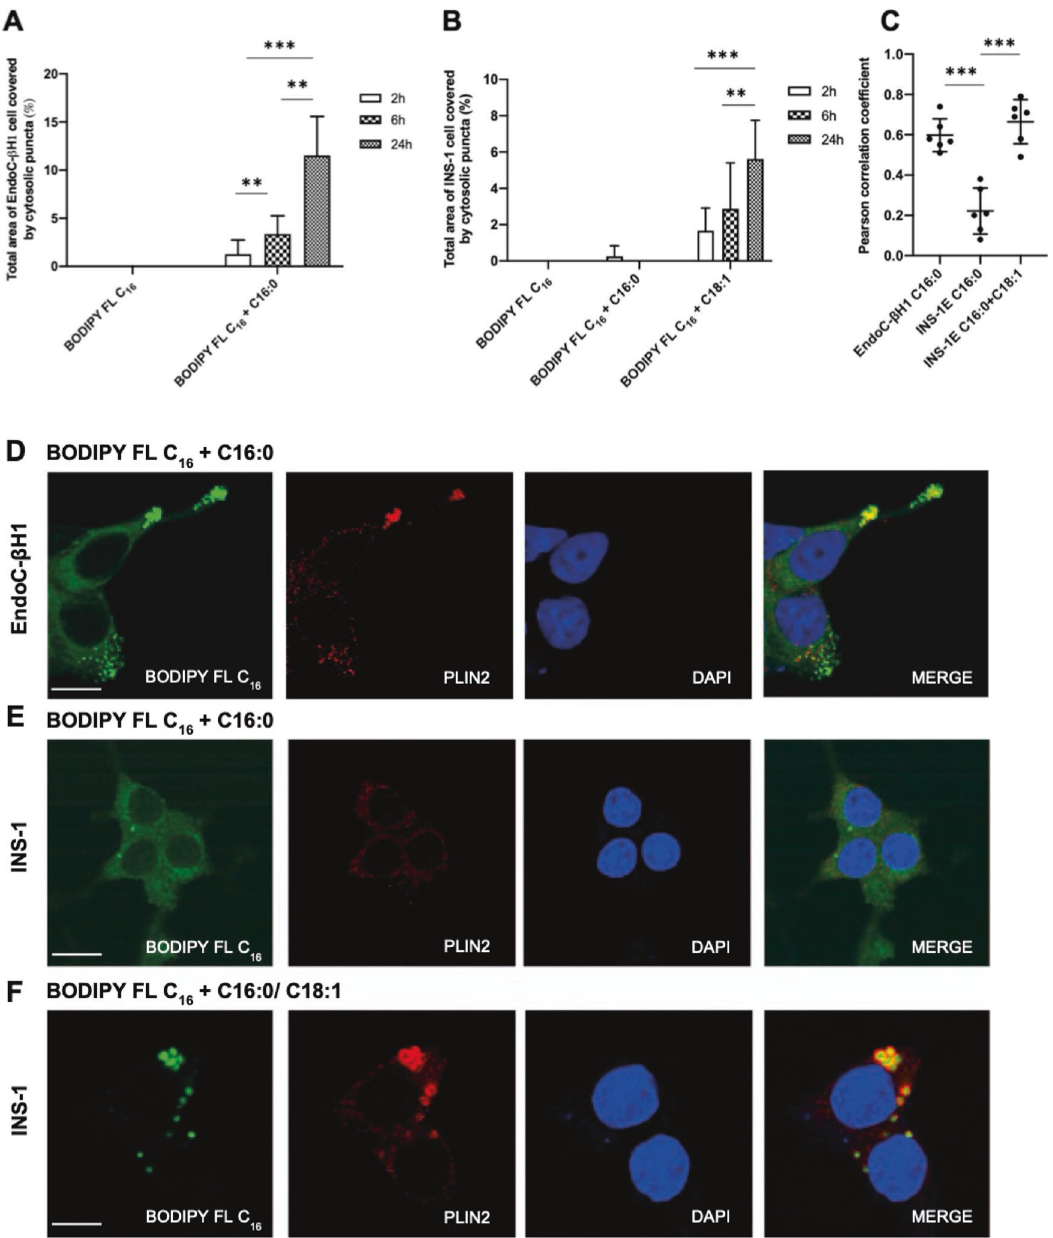
Fig. 2 Cytoplasmic lipid droplets form rapidly in EndoC- β H1 exposed to palmitate (C16:0), but this does not occur in INS-1E cells unless oleate (C18:1) is also present. Quanti fi cation of the total area of EndoC- β H1 ( A ) and INS-1E ( B ) cells covered by fl uorescent puncta after treatment with C16:0 (500 μ M) and BODIPY FL C 16 (400 nM) alone or in INS-1E cells, in combination with 250 μ M C18:1 for 2 h, 6 h or 24 h. Images were analysed using ImageJ/FIJI software where the area of cell covered by fl uorescent puncta was divided by the total cell area, and the results expressed as a percentage of the total. C Pearson correlation coef fi cient demonstrating the co-localisation BODIPY FL C 16 with PLIN2. Dots represent individual data points. Representative immuno fl uorescence staining of BODIPY FL C 16 (green), PLIN2 (red), and DAPI (blue) in EndoC- β H1 ( D ) and INS-1E ( E , F) cells following a 24 h treatment with C16:0 [500 μ M] and BODIPY FL C 16 [400 nM] alone or in INS-1E cells, in combination with 250 μ M C18:1 for 24 h. Merged images included to show co-localisation. Scale bars 10 μ m. Data represents mean + SD ( N = 3). ** p < 0.01, *** p < 0.001 as RESULTS Quantity-one (Bio-Rad) software and Fiji (ImageJ) software and blots deemed to be within the linear range were used for quanti fi cation. Effect of long-chain fatty acids on β -cell viability Con fi rming previous studies [3, 8], palmitate exposure for 24 h caused a dose-dependent increase in INS-1E cell death (Fig. 1A) Data analysis but this response was attenuated when the LC-MUFA, oleate, was Results are expressed as mean + standard deviation (SD). Statistical also present in the incubation medium (Fig. 1B). By contrast, analysis was carried out using GraphPad Prism version 8.0 (https://www. graphpad.com/scienti fi c-software/prism/). Statistical signi fi cance between incubation with palmitate failed to induce EndoC- β H1 cell death, mean values was calculated by ANOVA (with post hoc Tukey ’ s test) and even at concentrations of up to 1 mM and for exposure periods of regarded as signi fi cant when P < 0.05. 72 h (Fig. 1C). Thus, the LC-SFA palmitate is well tolerated by